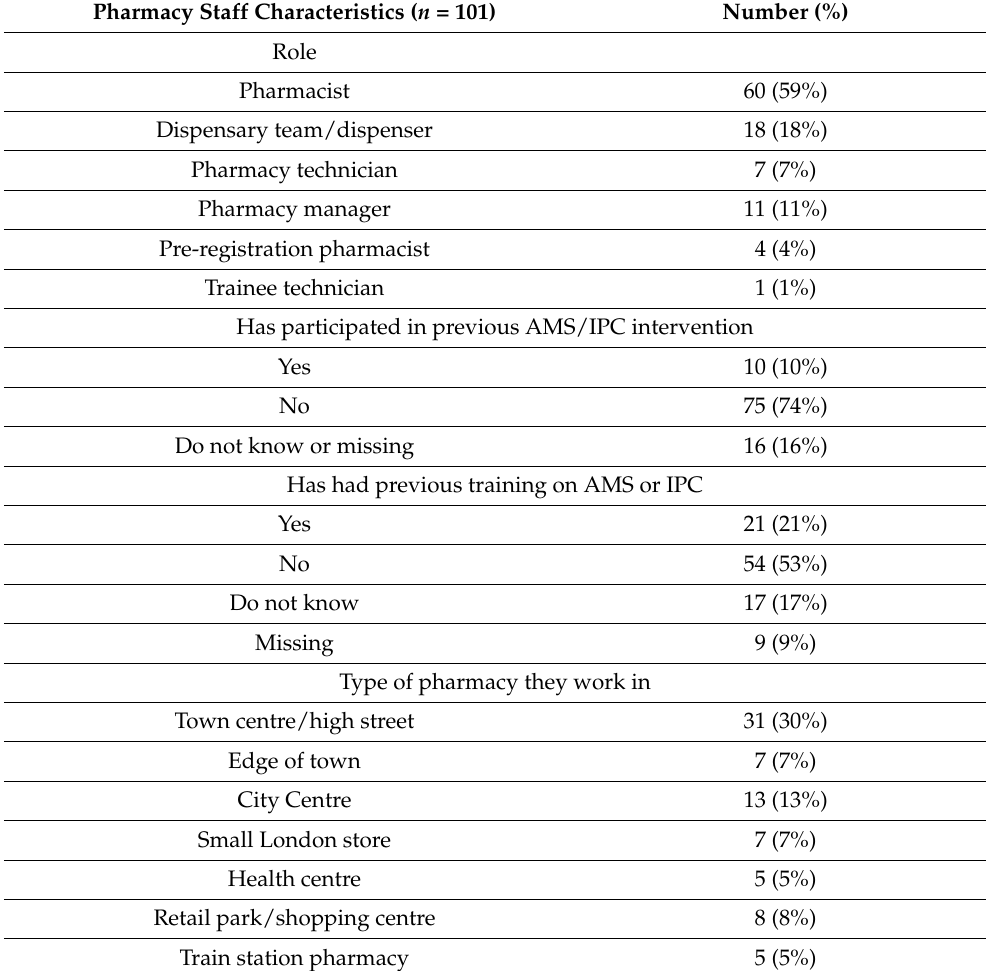
Table 1. Self-reported demographic and role-related data of community pharmacy staff who partici- pated in